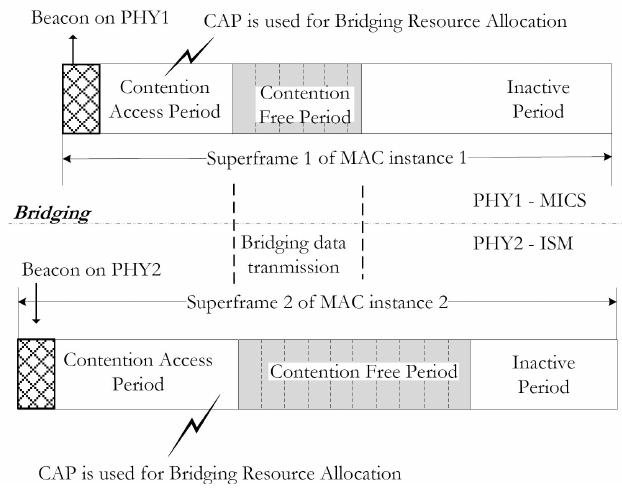
Figure 3. Bridging procedure: Two independent superframe